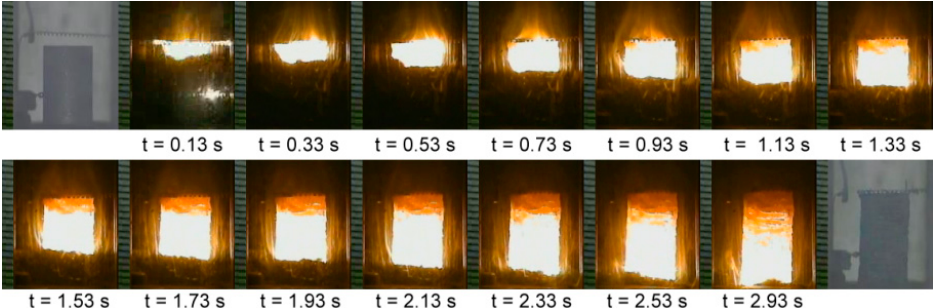
Figure 2. A typical sequence of self-sustaining combustion images recorded from R(1) with x = 3.